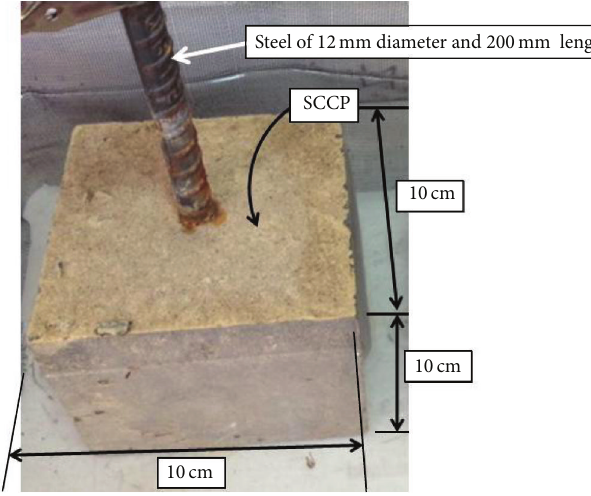
Figure 2: Concrete prism for accelerated corrosion test.